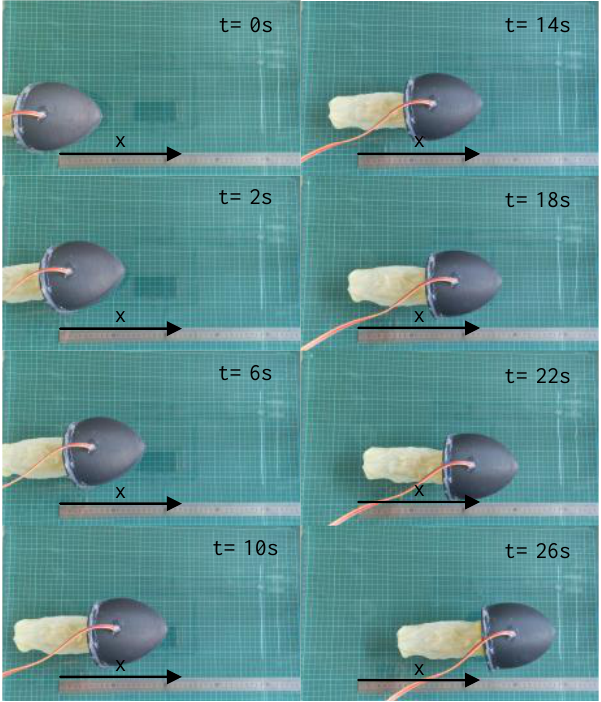
Figure 20. Swimming snapshots of the origami flexiball inspired bionic jellyfish robot.